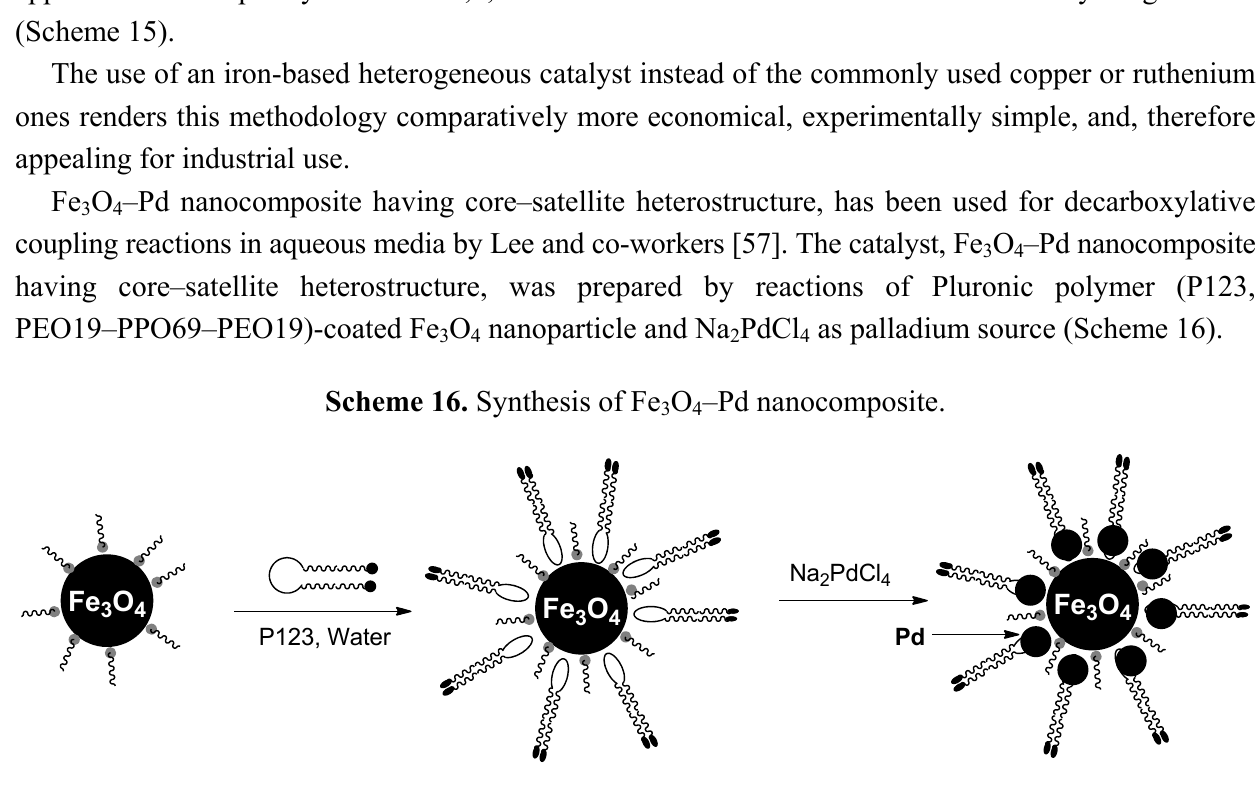
Table 1. Catalytic decarboxylic coupling reaction of allyl alkynoate, in aqueous media.